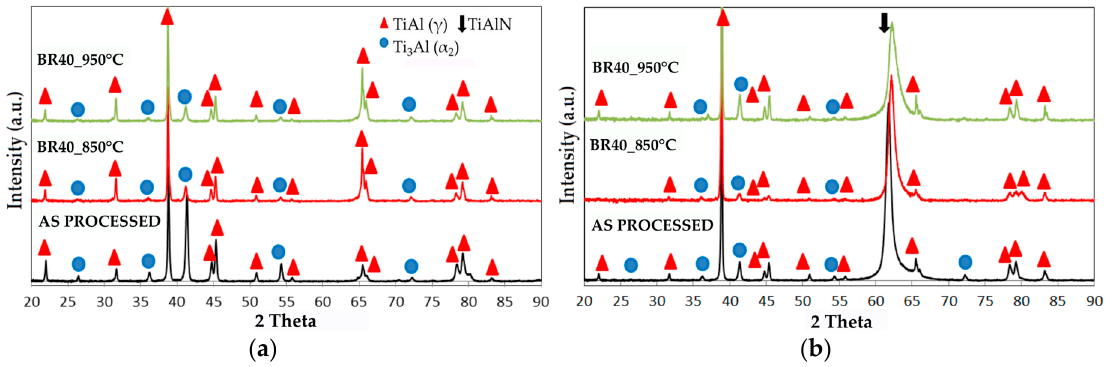
Figure 3. X-ray diffraction (XRD) spectra of samples surface before burner rig tests, after 40 cycles up to 850 °C and after 40 cycles up to 950 °C: ( a ) Ti-48Al-2Cr-2Nb alloy (substrate); and ( b ) TiAlN1 coating.